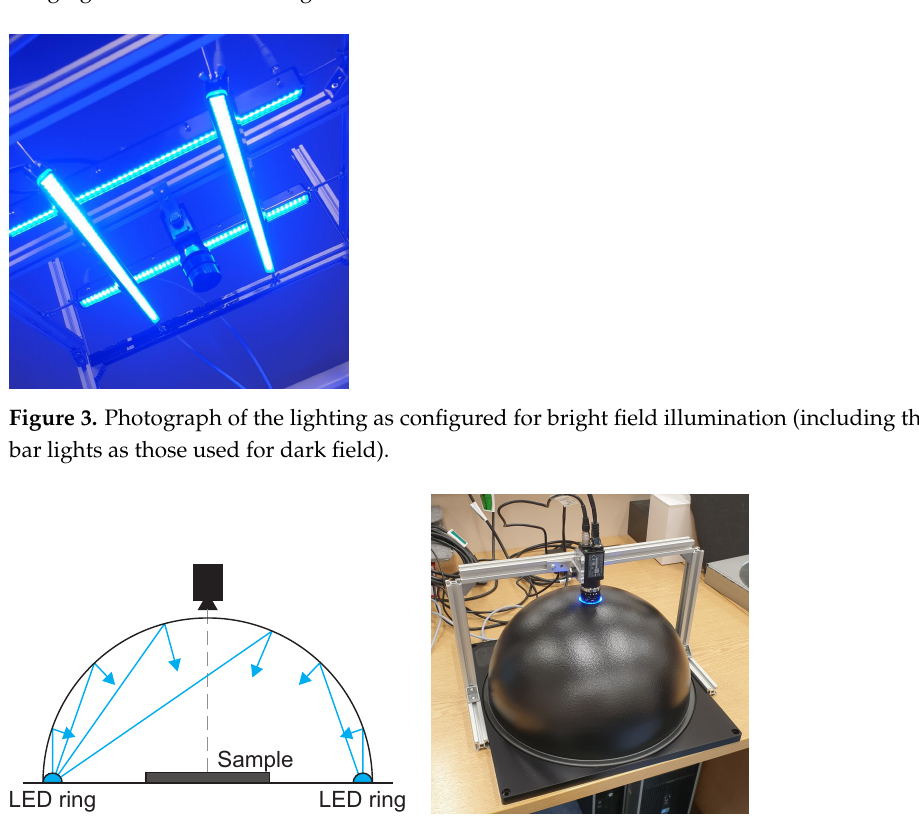
Figure 2. Dark field illumination rig. ( Left ): Schematic showing acceptable lighting positions for dark-field illumination (shaded area). For results in this paper, θ ≈ 30°, and the camera lens is approximately 40 cm from the surface. ( Right ): Photograph of the capture rig, including four MBJ Imaging SBL-0130-BE-S bar lights.